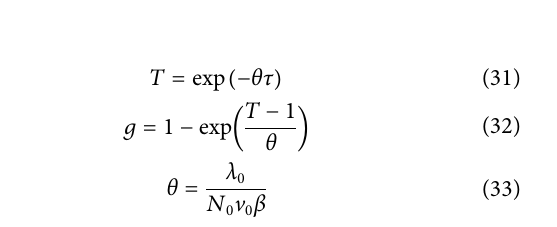
Frontiers in Energy Research |